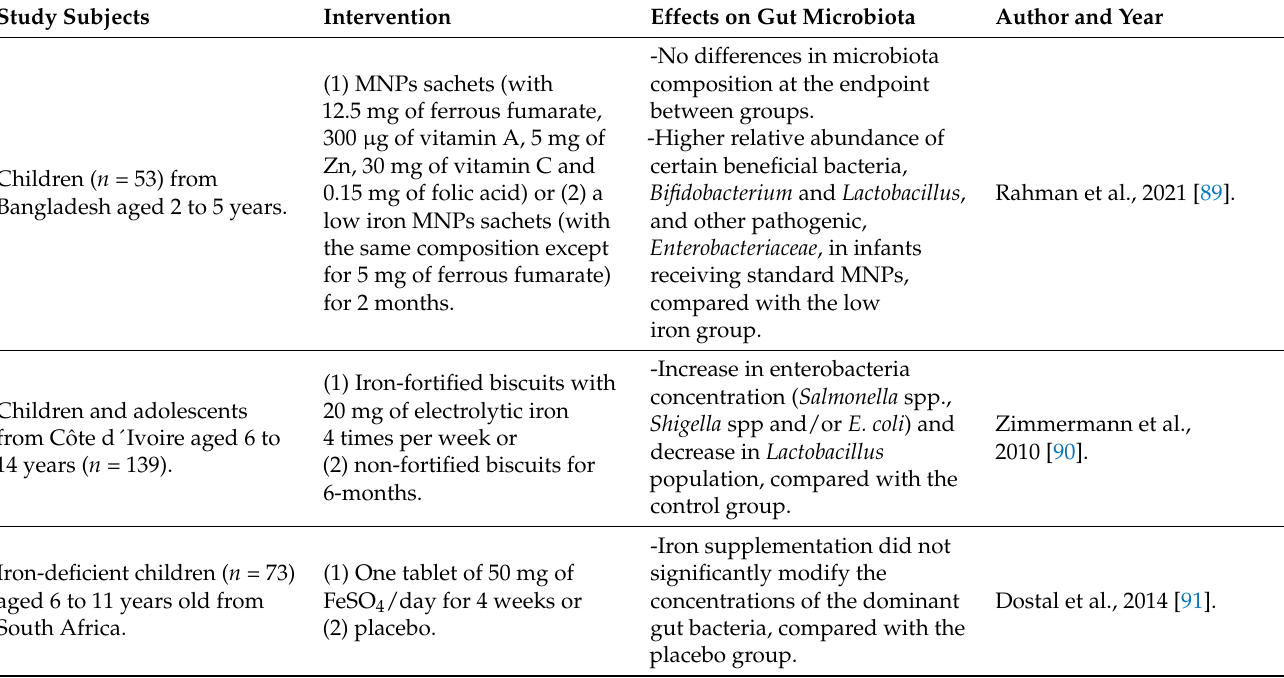
Table 2. Summary of the effects of the intervention studies performed in children and adolescents on gut